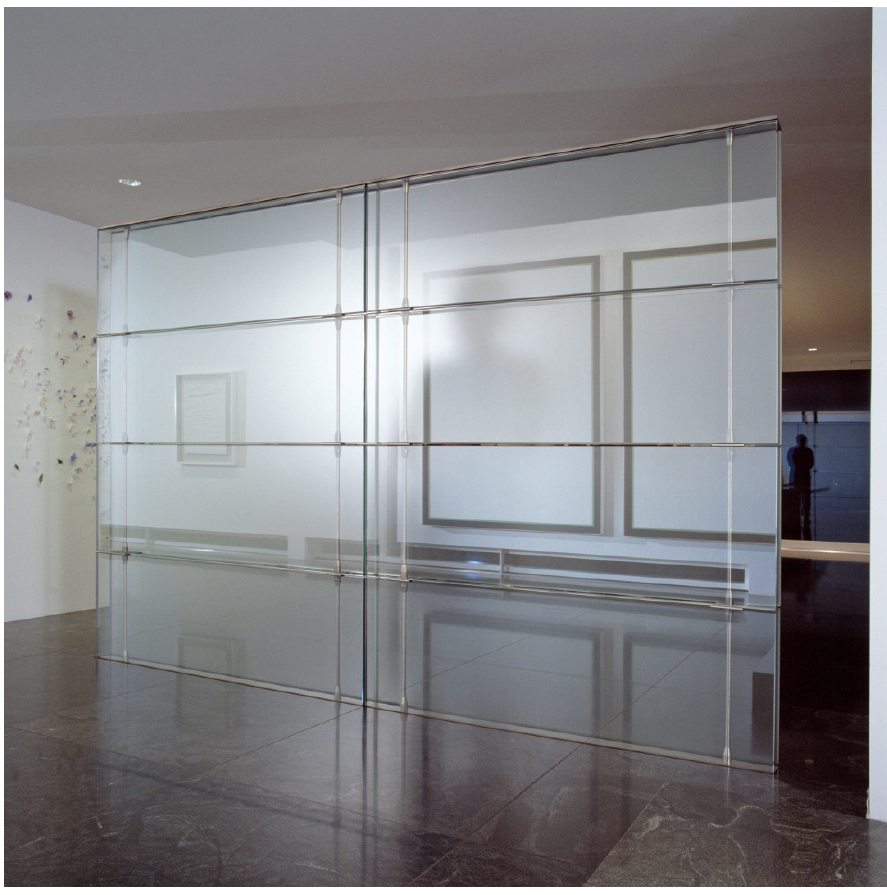
Figure 6: view of the Retracting Screen from the gallery at